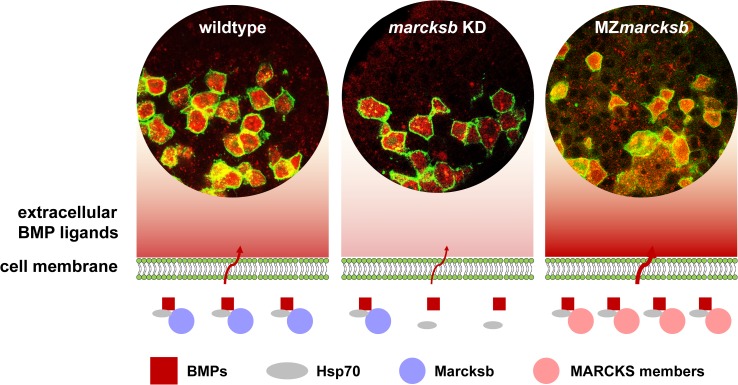
A model shows MARCKS-mediated BMPs secretory process in wildtype embryos, marcksb morphants and MZmarcksb embryos.A model shows MARCKS-mediated BMPs secretory process in the cells of wildtype embryos, marcksb morphants (marcksb KD) and MZmarcksb embryos. In wildtype embryo, Marcksb dominantly interacts with Hsp70 to mediate the secretion of BMPs; in marcksb morphant embryos, reduction of Marcksb proteins interfere the secretion of BMPs; in MZmarcksb embryos, marcksa, marcksl1a and marcksl1b (MARCKS members) are up-regulated maternally and hsp70.3 is up-regulated zygotically, which leads to a massive production of functional MARCKS-Hsp70 complex and increased extracellular level of BMPs.